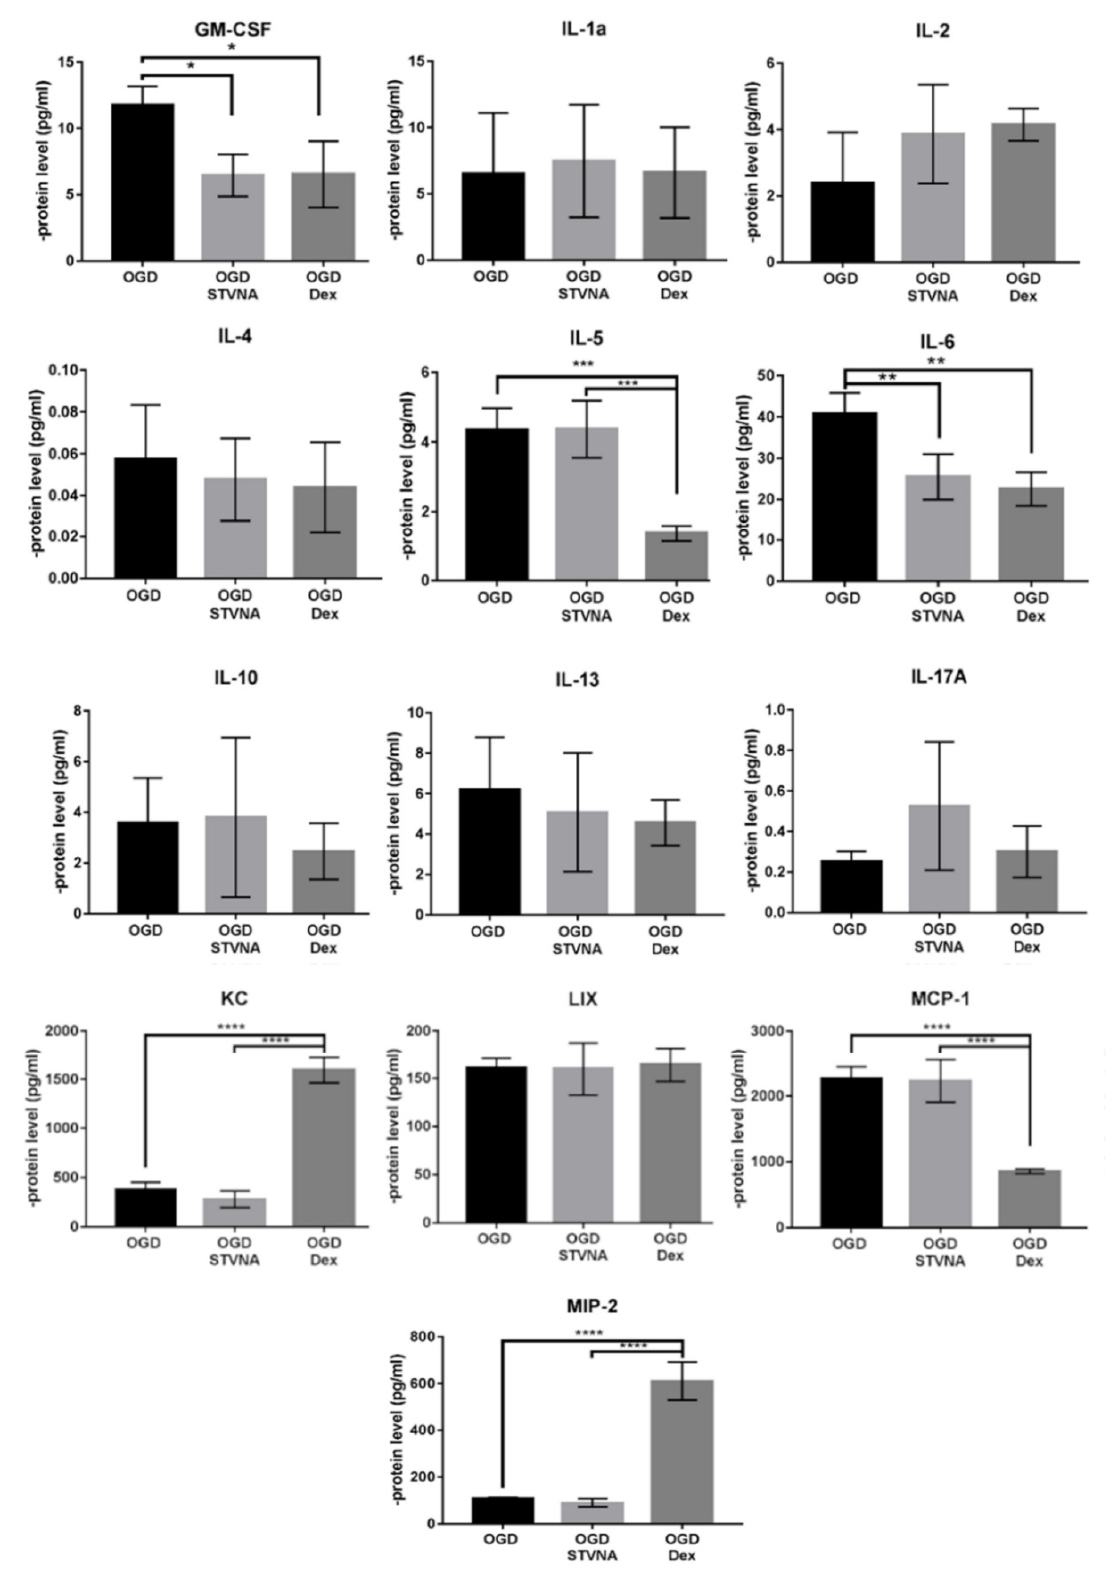
Figure 4. Multiplex assay of T-cell panel cytokines confirms reduction of OGD-induced IL-6 expres- sion upon treatment with 20 mg/L STVNA, * p ≤ 0.05, ** p ≤ 0.01, *** p ≤ 0.001, **** p ≤ 0.0001, n = 4.